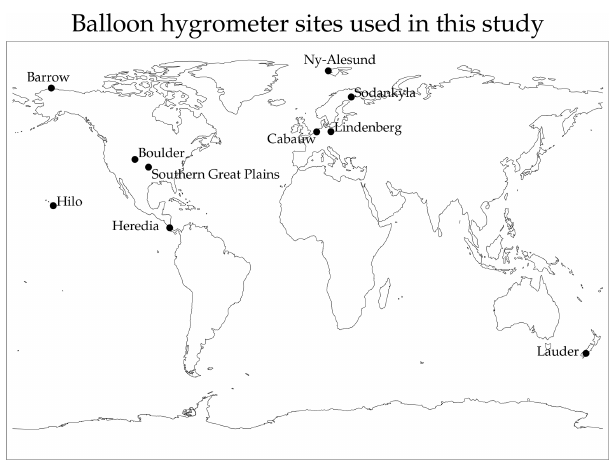
Figure 1. Balloon frost-point launch sites used in this